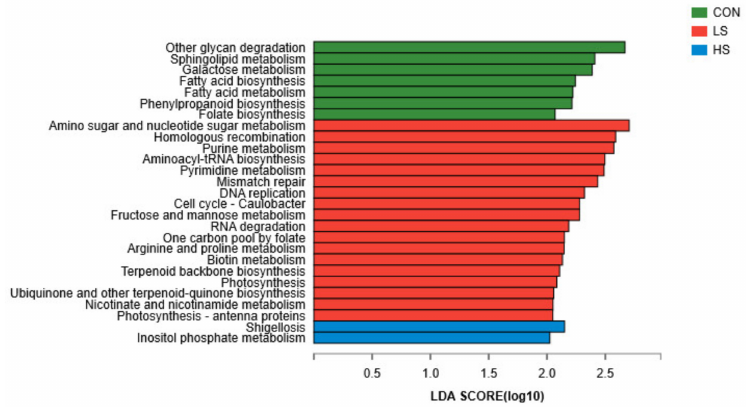
Figure 5. Effect of selenium yeast on the differential kyoto encyclopedia of genes and genomes func- tions of significantly enriched metabolic pathways. CON = basal diet; LS = basal diet + 2.4 mg/kg SY; HS = basal diet + 4.8 mg/kg SY.